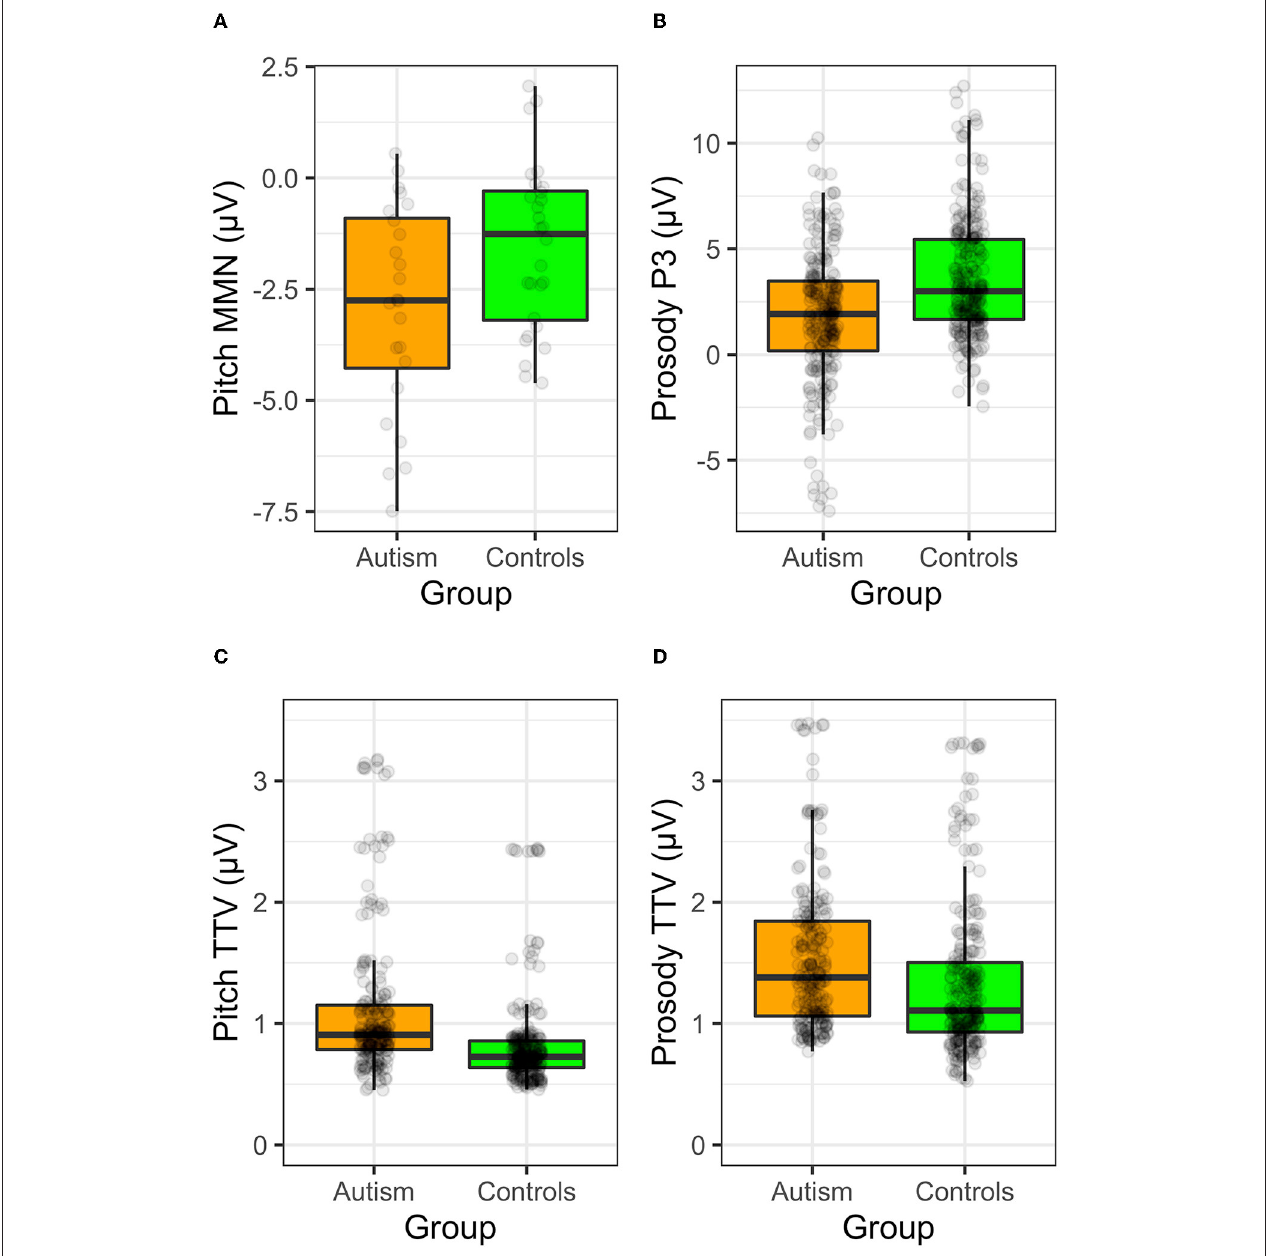
FIGURE 10 | ERP responses to the (A) MMN to the long tone trains, (B) the P3 to the change to frustration utterance, (C) TTV to the pitch tones, and (D) TTV to the prosodic utterances, shown separately for individuals with autism and neurotypical controls.